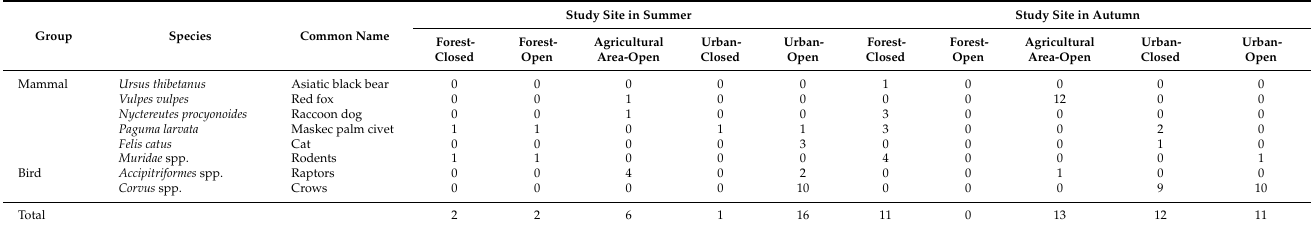
Table 2. Frequency of vertebrates that removed carcasses captured by camera traps. The number of camera days at each study site was 60 days in summer and 45 days in